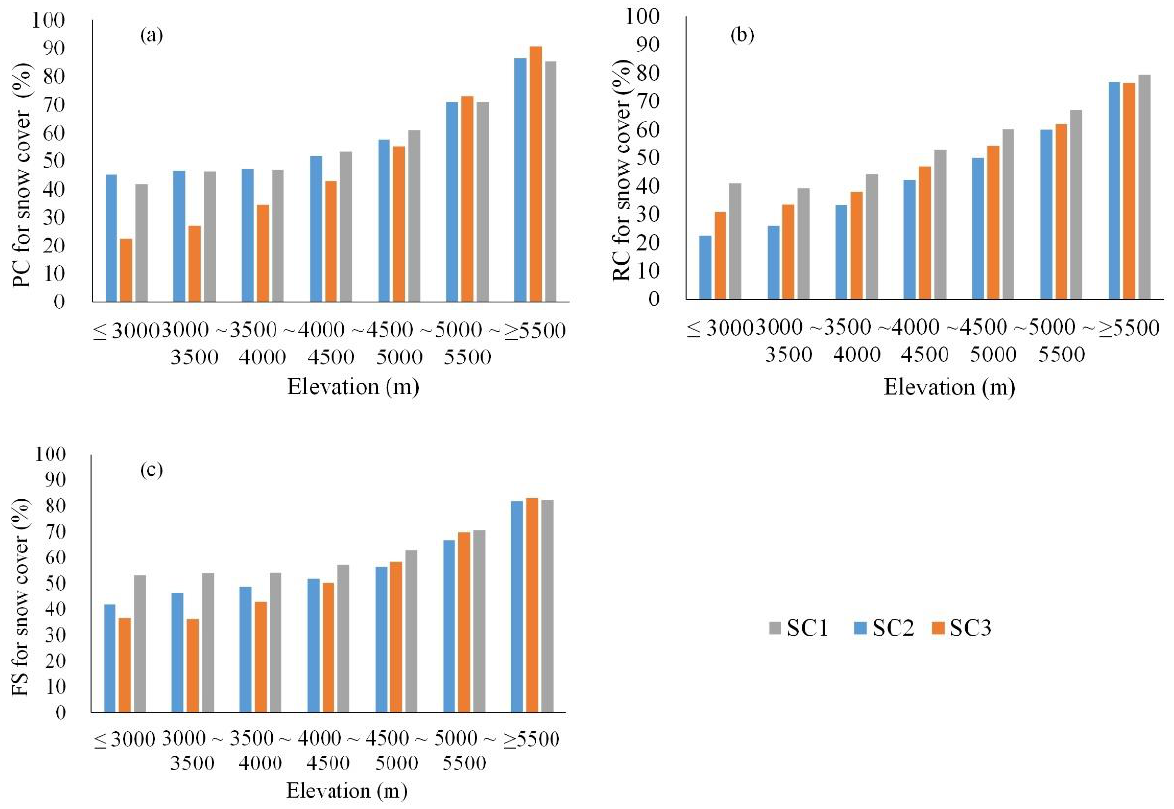
Figure 3. Validation results for cloud-gap-filled snow cover within different altitude regions. ( a ) The validation results of PC, ( b ) The validation results of RC, ( c ) The validation results of FS. FS, PC, and RC were the average of F1-score, precision, and recall, respectively, during 2002–2010. SC1, SC2, and SC3 were the snow cover products of the combined MOD10A1F and MYD10A1F (SC1) developed by Huang et al. [28] and Qiu et al. [29], respectively.